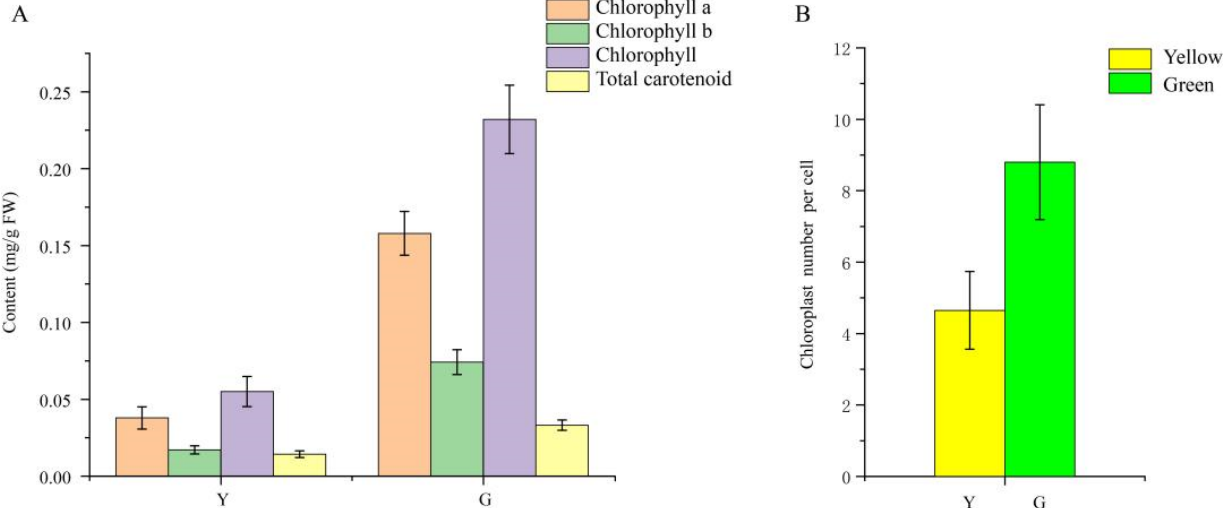
Figure 3. Pigment accumulation and the average number of chloroplasts per cell in P. SCBG COP15 and the yellow mutant. ( A ) Chlorophyll a, chlorophyll b, chlorophyll, and total carotenoid contents